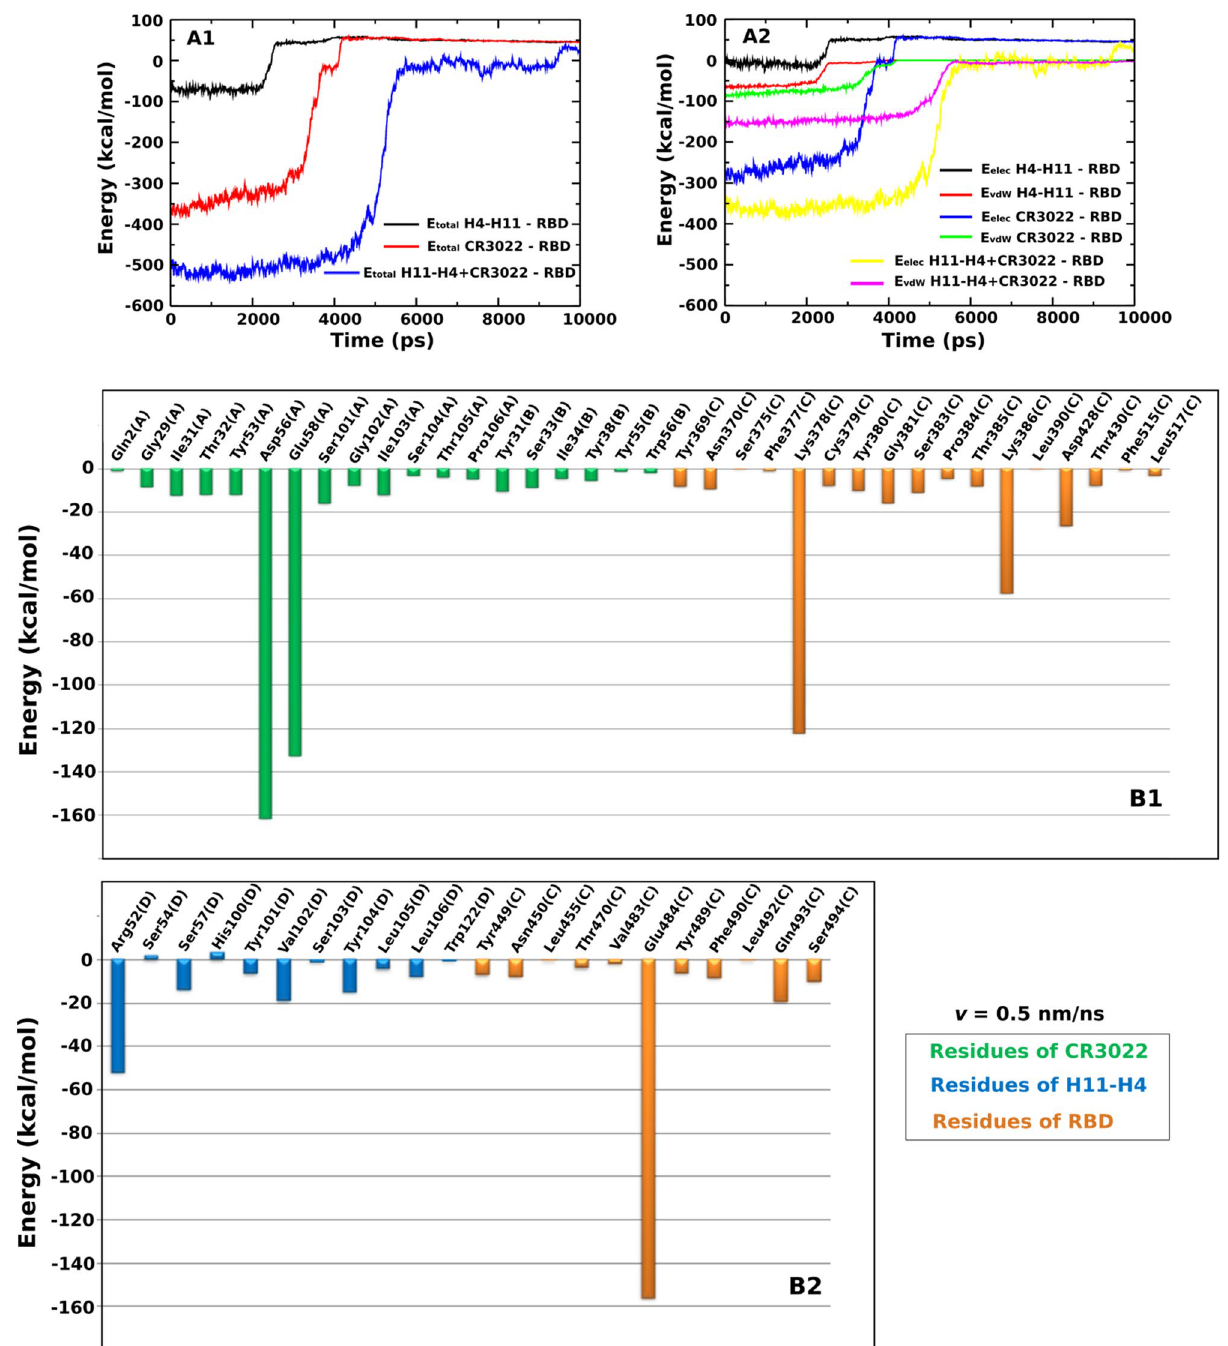
Figure 4. Time dependence of the total non-bonded interaction energy (sum of electrostatic and vdW) ( A1 ) , and electrostatic and vdW interaction energies ( A2 ) of the H11-H4-RBD, CR3022-RBD and H11-H4 + CR3022- RBD complexes. Total non-bonded interaction energy of residues located at the binding region of H11-H4-RBD ( B1 ) and CR3022-RBD ( B2 ). The results were obtained for a time window [0, t max ] and averaged from five independent SMD runs at pulling speed v = 0.5